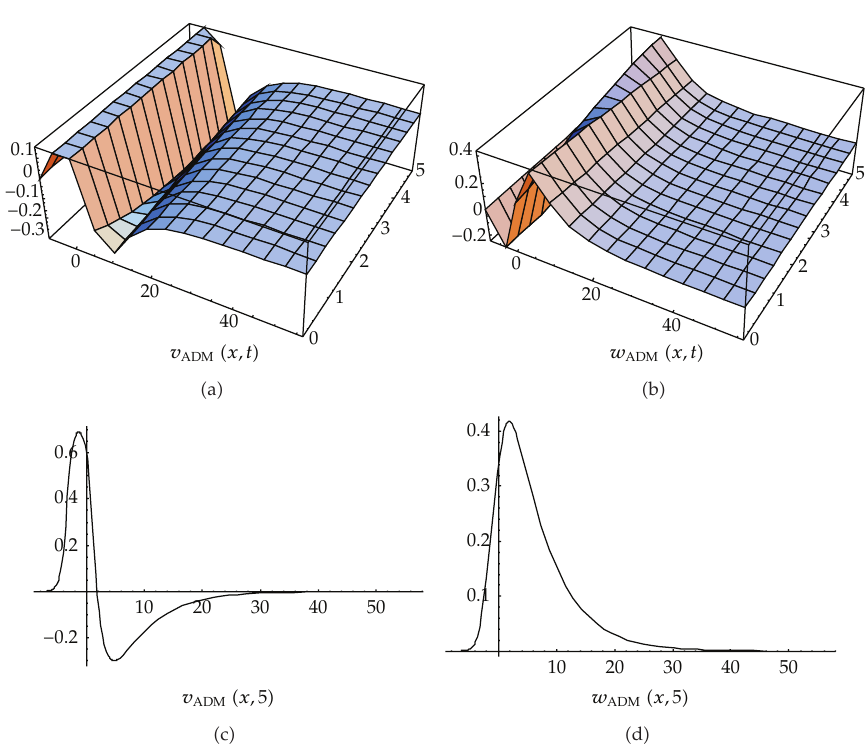
Figure 2: The approximation solutions v (cid:2) x,t (cid:3) , w (cid:2) x,t (cid:3) .